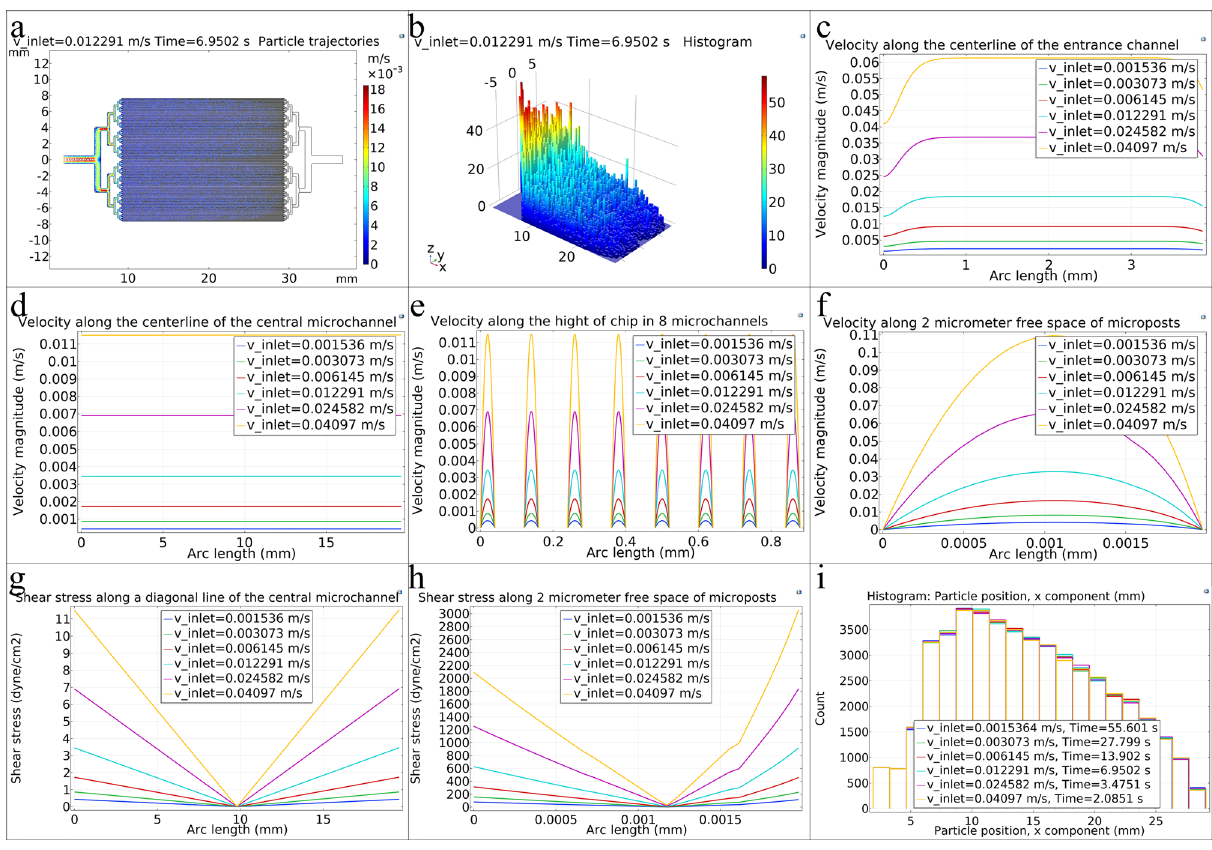
Figure 3. ( a ) Cell trajectories in the microfluidic chip when the first cells reach the terminal microposts. The cells’ color indicates their velocity (m/s). A scale factor of 4.9 is used for cell radius for better demonstration. ( b ) Histogram plot of cells distribution along the microfluidic chip when the first cells reach the terminal microposts. ( c ) Velocity changes along the input channel’s centerline. ( d ) Velocity changes along a cut line on the microfluidic chip’s central microchannel centerline (before reaching the central microchannel’s terminal microposts). ( e ) Velocity changes along the microfluidic chip’s height in eight consecutive microchannels. ( f ) Velocity changes in the direction of 2 μm vertical free distance between the micropost and the channel wall. ( g ) Shear stress changes along a diagonal cut line from the central microchannel’s bottom-left point to its top-right point (before reaching the central microchannel’s terminal microposts). ( h ) Shear stress changes in the direction of 2 μm vertical free distance between the micropost and the channel wall. ( i ) Histogram of cell position along the microfluidic chip. All data were obtained for the microfluidic chip with 40 μm microchannels, and ( c – i ) were obtained for different inlet velocities in the microfluidic